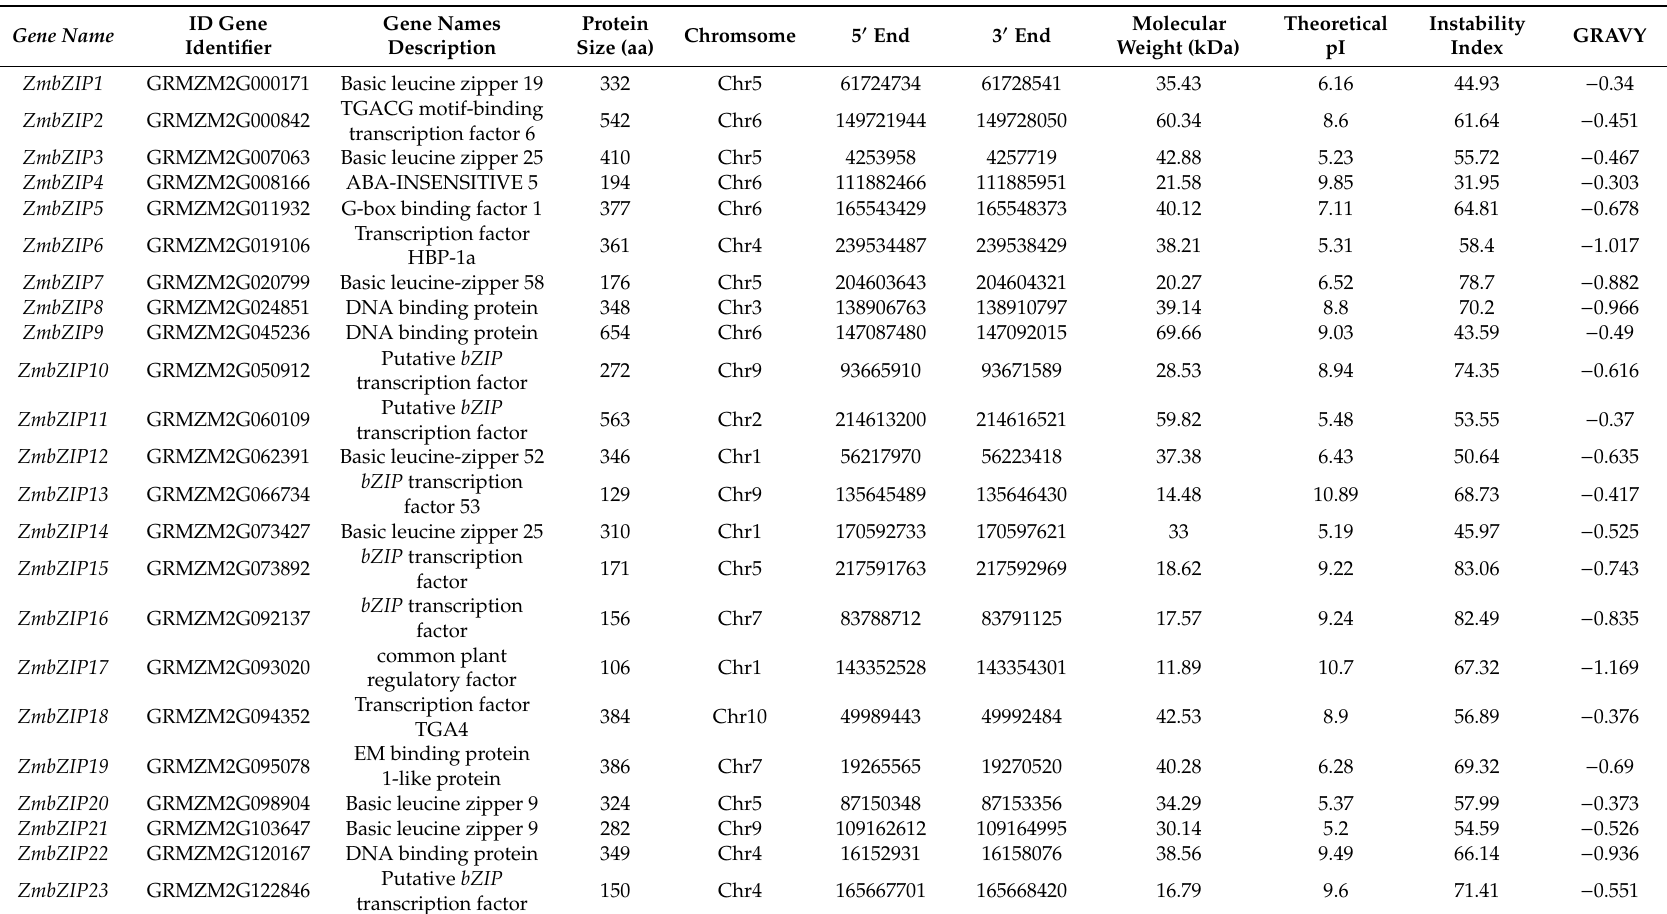
Table 1. The detailed information of maize basic leucine zipper ( bZIP ) family